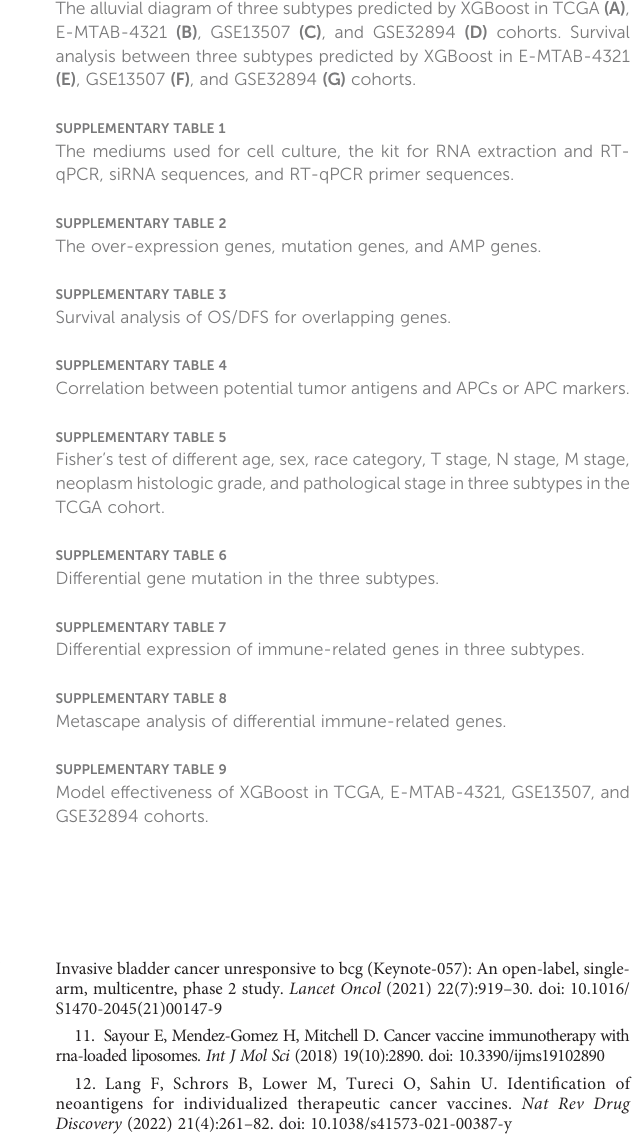
SUPPLEMENTARY TABLE 1 The mediums used for cell culture, the kit for RNA extraction and RT- qPCR, siRNA sequences, and RT-qPCR primer sequences. SUPPLEMENTARY TABLE 2 The over-expression genes, mutation genes, and AMP genes. SUPPLEMENTARY TABLE 3 Survival analysis of OS/DFS for overlapping genes. SUPPLEMENTARY TABLE 4 Correlation between potential tumor antigens and APCs or APC markers.